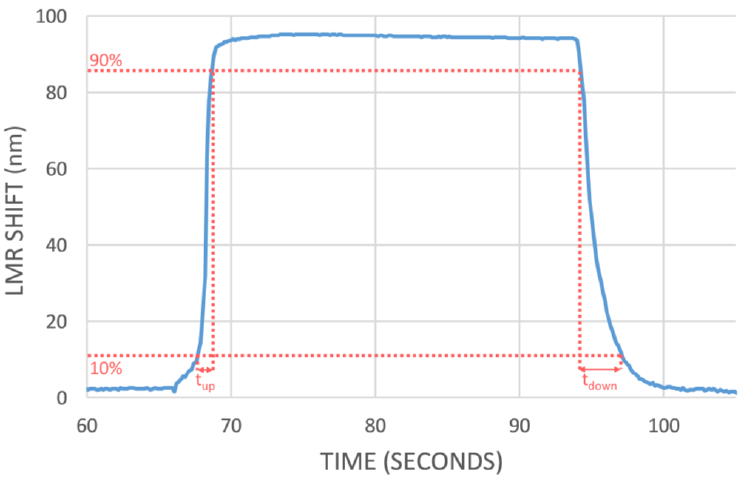
Figure 7. Single cycle of the dynamic response where the calculation of the rise time (t up ) and the fall time (t down ) is shown.